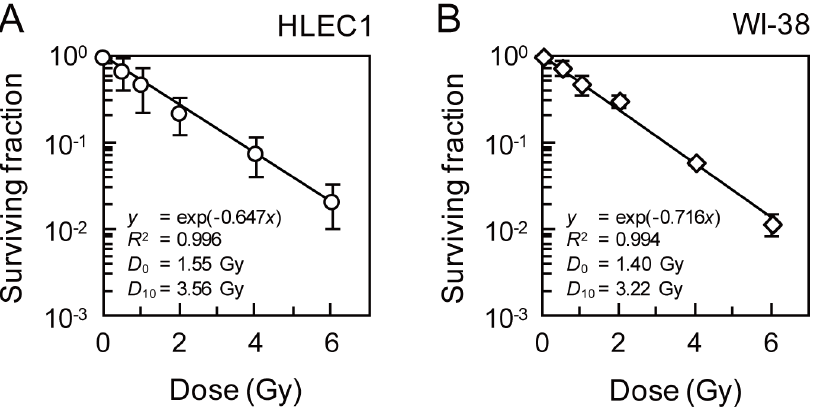
Figure 3. Clonogenic survival of HLEC1 (A) and WI-38 (B). Within 1 h after exposure to indicated dose of X-rays at a dose rate of 0.43 6 0.01 Gy/ min, cells were reinoculated for colony formation and incubated for 14 days at which time they were fixed and stained. At the time of reinoculation, CPD of HLEC1 and WI-38 was 11.0 and 32.0, respectively (n.b., CPD 11.0 was experimentally available youngest HLEC1 in our hand). The plating efficiency of HLEC1 and WI-38 was 1.6 6 0.6 and 19.5 6 3.6%, respectively. Curves were fitted to the exponential equation y =exp ( 2 kx ), and D 0 and D 10 were calculated as 1/ k and [ln(1/0.1)]/ k , respectively. R 2 , correlation coefficient square. The data are presented as means and SD of three independent experiments with quadruplicate measurements.